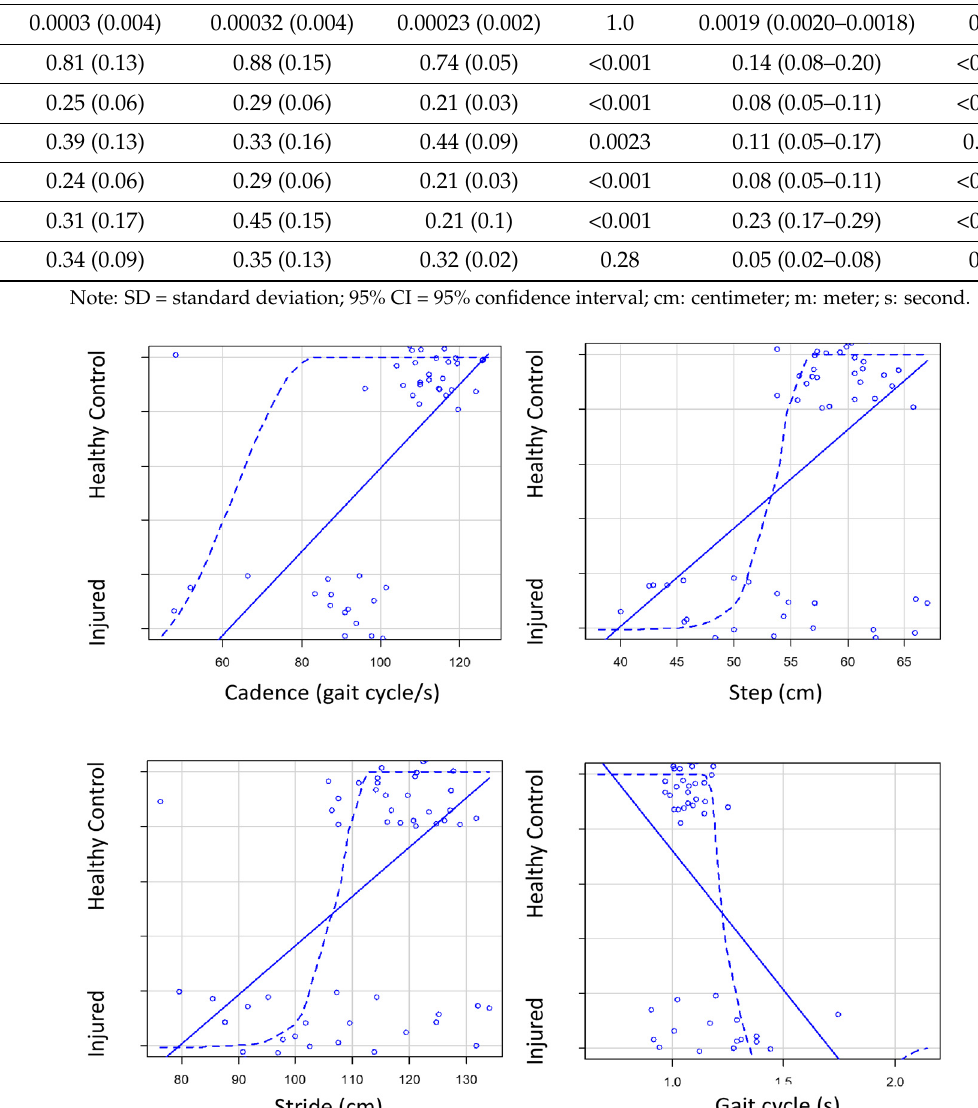
Figure 3. Scatter plots on the variables with the most significant results. Constant line is the linear regression and spot line is the logistic regression of the variables. 4. Discussion The aim of the present study was to determine the level of association of the spatio- temporal gait parameters in both subjects with and without plantar fasciopathy. The sec- ond objective was to analyze whether differences in the spatio-temporal gait parameters exist between groups. The spatio-temporal gait parameters in people with bilateral plantar fasciopathy that had statistical significance when compared to the control group were: decreased step length ( p < 0.001), increased contact phase ( p < 0.001), increased double support ( p < 0.001), increased response to load ( p < 0.001), increased pre-swing ( p < 0.001), increased gait cycle